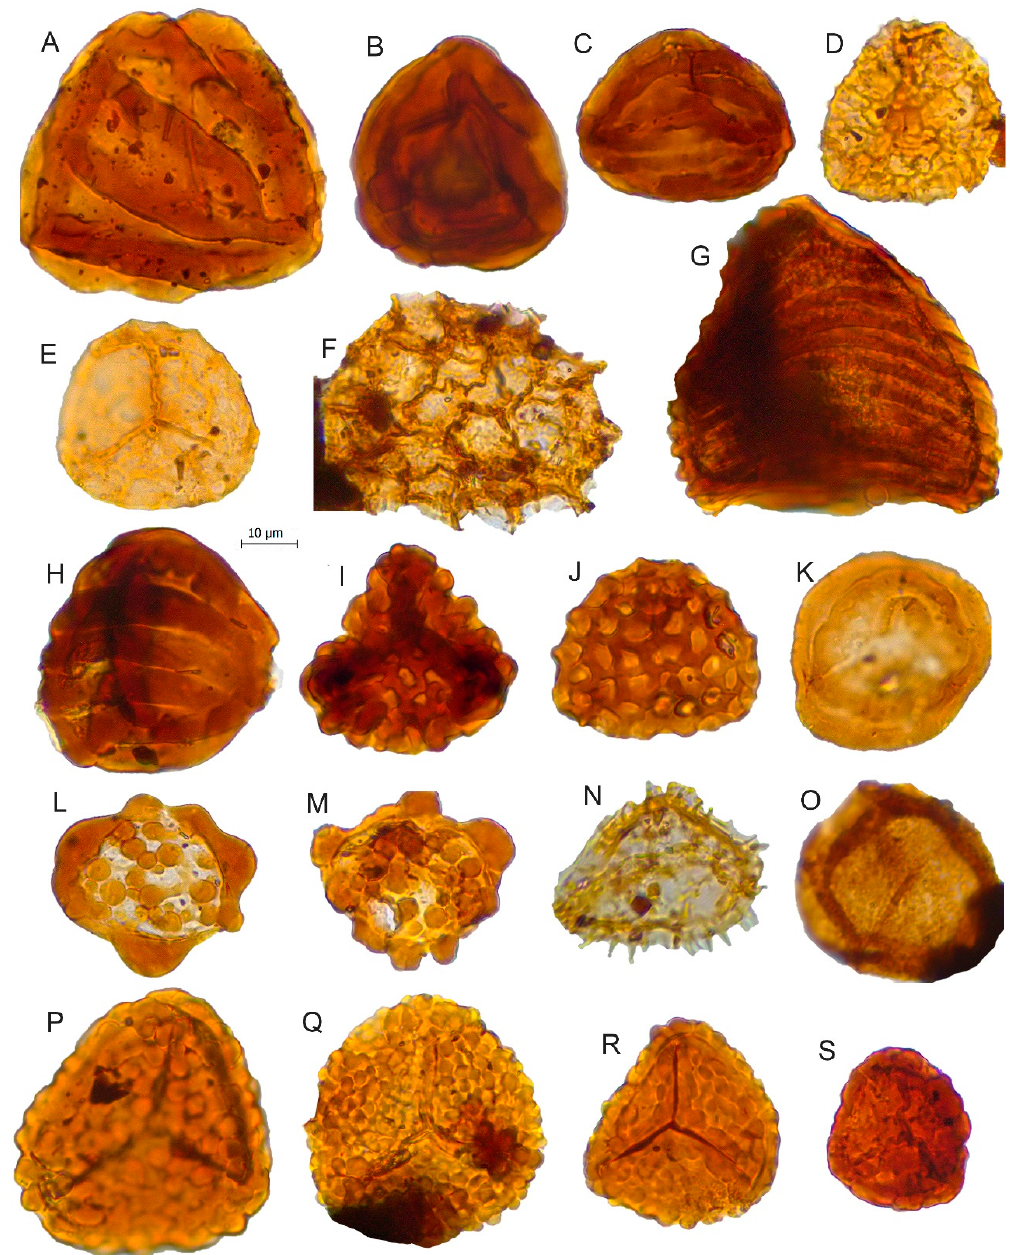
Figure 6. Scale bar: 10 µm. ( A ) Striatella balmei , JVLP-2-2-V421 ; ( B ) Striatella seebergensis , JVLP-1-1-X413 ; ( C ) Striatella cooksoniae , JVLP-3-2-F332 ; ( D ) Retitriletes pseudoreticulatus , JVLP-B-2-M422 ; ( E ) Retitriletes sp., JVLP-2-4-M252; ( F ) cf. Retitriletes sp ., JVLP-2-4-U373; ( G ) Contignisporites globulentus , JVLP-1-2-N340; ( H ) Contignisporites fornicatus , JVLP-3-2-M503; ( I ) Ischyosporites marburgensis , JVLP-2-2-B220; ( J ) Klukisporites lacunus , JVLP-3-2-K531; ( K ) Polycingulatisporites crenelatus, JVLP-3-1-W300;